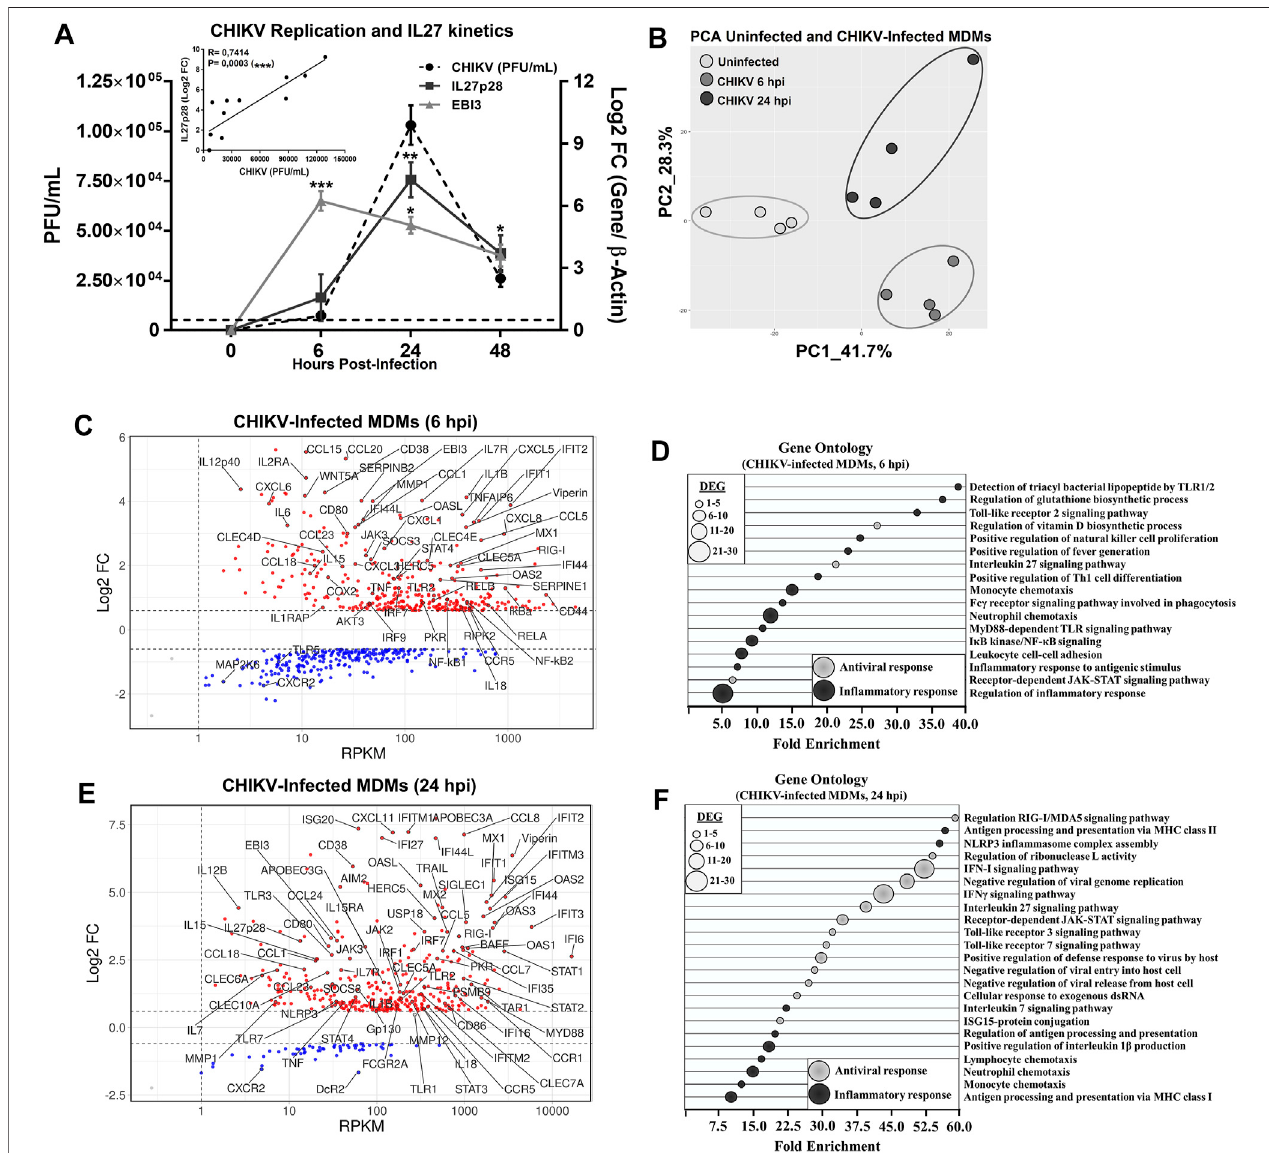
FIGURE 1 | CHIKV infection induces the expression of both subunits of IL27 and activated a dynamic transcriptional pro fi le in human MDMs. Human MDMs cultures were left uninfected or infected with CHIKV at MOI 5. Culture supernatants were obtained at 6, 24, and 48 hpi, and quanti fi cation of CHIKV PFU/mL was performedbyplaqueassayonVerocells.MDMslysateswereobtainedat6,24,and48 hpi,andRT-qPCRwasperformed.CHIKVreplication,IL27p28 andEBI3mRNA expression kineticsin human MDMs (A) . Dataarepresentedasthe mean± SEM.Mann-Whitney test wasperformed. Signi fi cantresults are de fi ned as p < 0.05(*), p < 0.01(**)and p < 0.002(***). n =4.Pearson ’ scorrelationbetweenCHIKVreplication(PFU/ml)andIL27p28mRNAexpression(Log2FC)inCHIKV-infectedMDMs (A) . Signi fi cant results are de fi ned as p < 0.05 (*), p < 0.01 (**) and p < 0.002 (***). Human MDMs cultures were left uninfected or infected with CHIKV at MOI 5. Cell lysates wereobtainedat6and24 hpiandRNA-seqwasperformed.PCAplot (B) ofdifferentiallyexpressedgenes(DEG)interrogatedbyRNA-Seq.MAplots (CandE) andGO enrichment analysis (D and F) from DEG regulated in CHIKV-infected MDMs at 6 and 24 hpi, respectively.DEG in CHIKV-infected MDMs was selected from genes with an FDR < 0.05 and |Log2 Fold Change (CHIKV-infected MDMs/Uninfected MDMs) | > 0.6. To quantify mRNAs abundance, we use the Reads per kilobase per million mapped reads (RPKM). n =